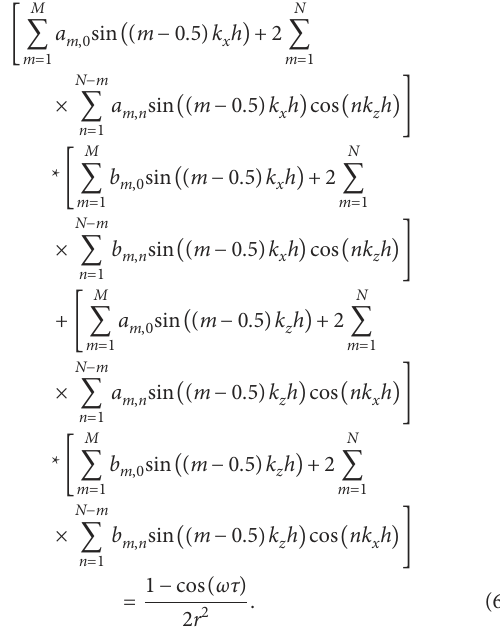
cross-rhombus stencil for above equations